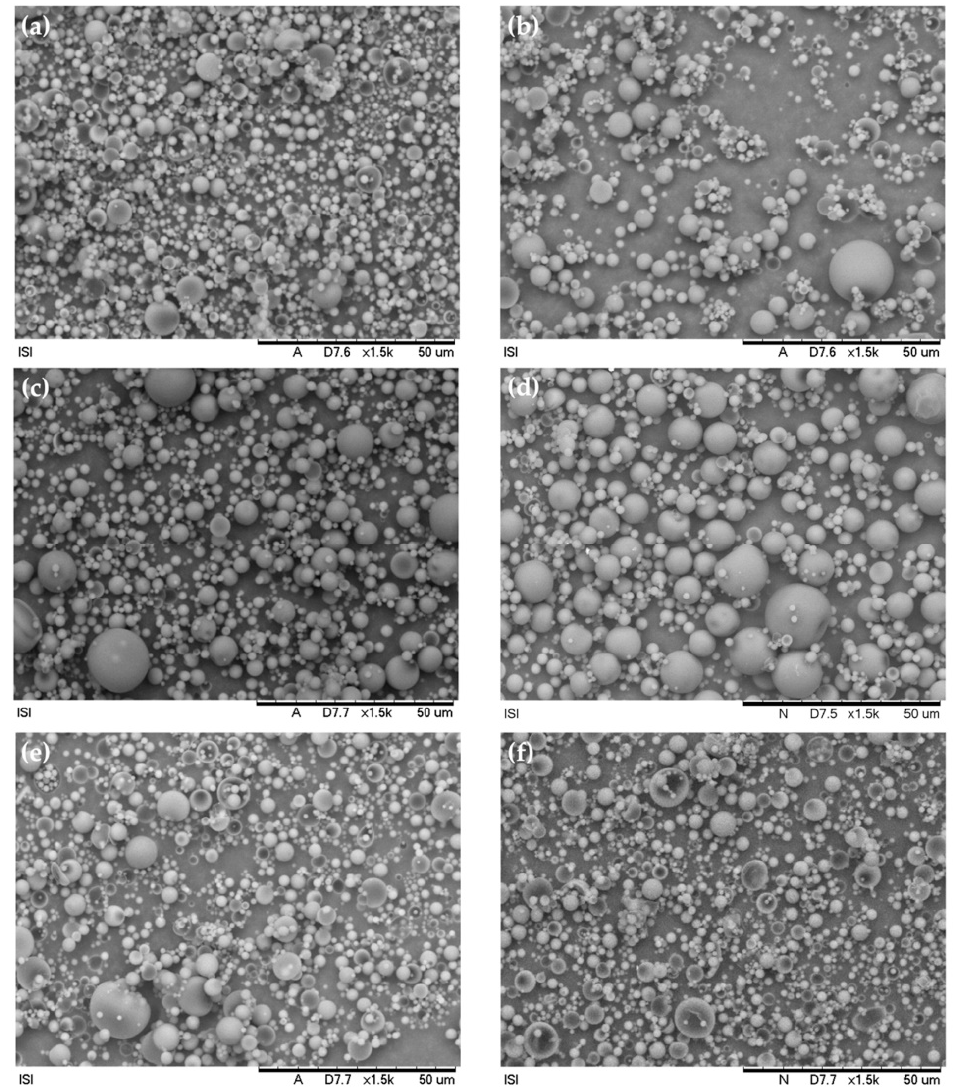
Figure 4. SEM scans of CMC.BTA microspheres attained by the technique of spray-drying in dis- tinctive empirical situations: ( a ) 440 L/h and 170 °C; ( b ) 600 L/h and 170 °C; ( c ) 440 L/h and 180 °C; ( d ) 600 L/h and 180 °C; ( e ) 440 L/h and 190 °C; and ( f ) 600 L/h and 190 °C. Reprinted with permission from Ref. [18]. MDPI (2022).